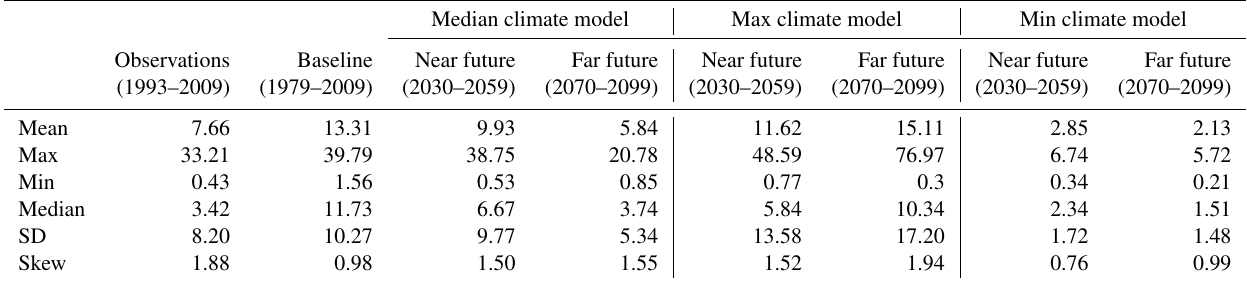
Figure 2. Flow chart of the methodology employed. Table 1. Statistical analyses of annual streamflow (m 3 s − 1 ) simulated for the baseline (1979–2009) and two future periods (2030–2059 and 2070–2099) for the median, minimum (driest), and maximum (wettest) climate